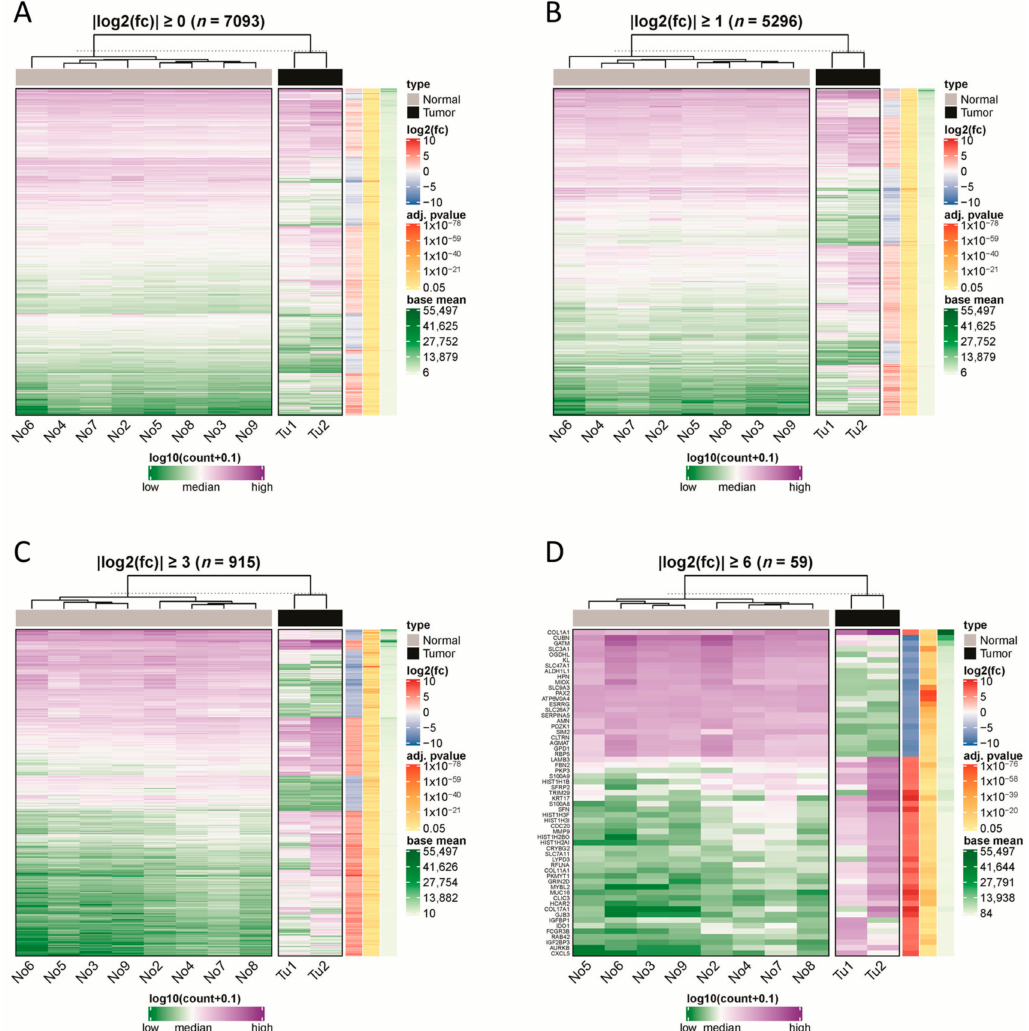
Figure 2. Hierarchical clustering of samples using di ff erentially expressed protein-coding genes. We used di ff erent-fold changes as a threshold to filter significantly di ff erentially expressed protein-coding genes (adjusted p -value ≤ 0.05). Read counts of the genes were used to cluster normal and tumor samples based on their Euclidian distance. In addition, we annotated the selected genes with their log2fold-change, adjusted p -value and base mean of their read counts. The thresholds used were ( A ) | log2fold-change | ≥ 0, ( B ) | log2fold-change | ≥ 1, ( C ) | log2fold-change | ≥ 3, and ( D ) | log2fold change | ≥